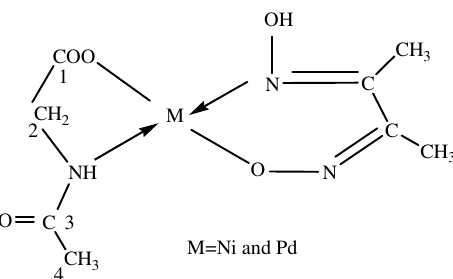
Figure 2. Square planer geometry for the [M(D)(G)]